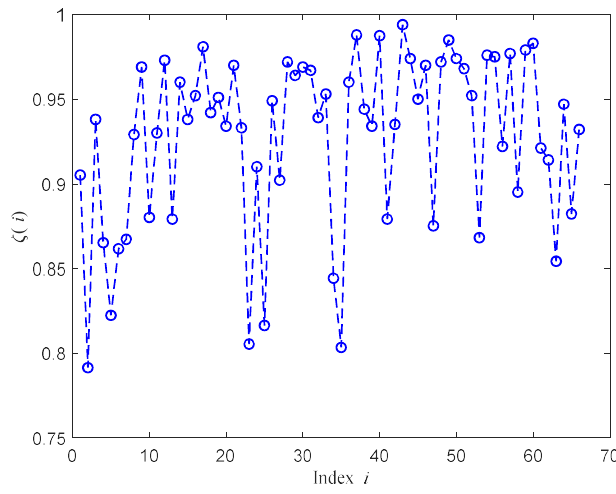
Figure 15. The maximum of fidelity factor versus the response index i .